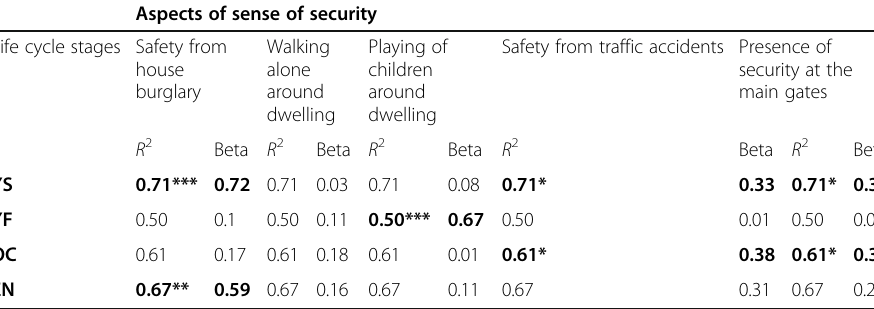
Table 10 Regression analysis results for sense of security Aspects of sense of